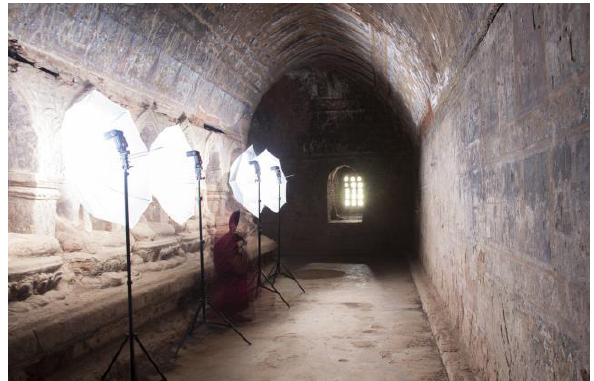
Figure 4. The photogrammetric lighting setup